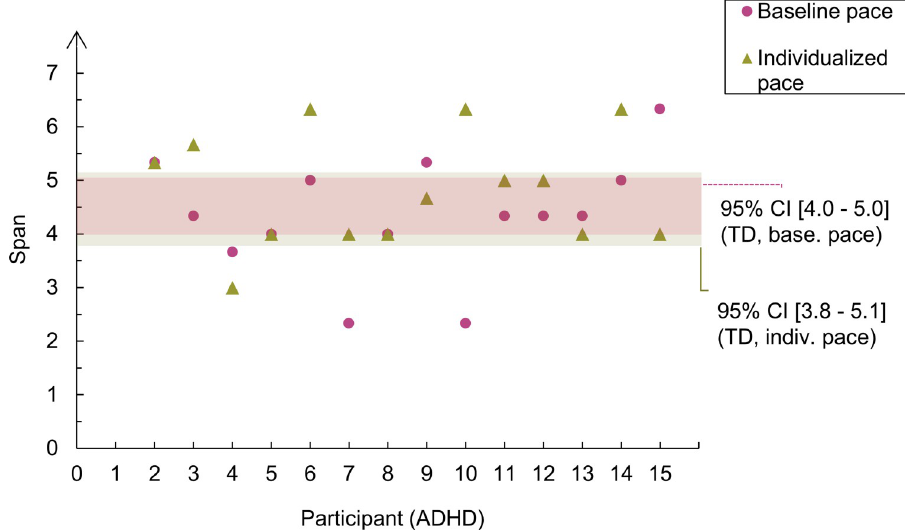
Fig 8. Individual spans in the ADHD group per pace condition in Experiment 2. Each data point in the graph represents an individual span in the ADHD group. The shaded zones represent the 95% confidence intervals of the mean in the control